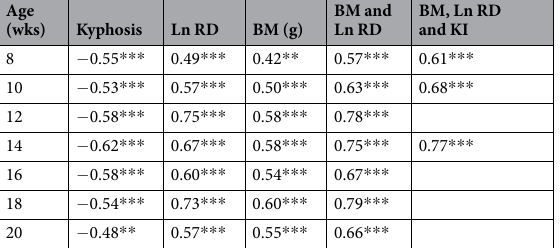
Table 1. Correlates of dko lifespan. Correlations (pearsons r) between lifespan and kyphosis index (KI), the natural logarithm of running distance (Ln RD), body mass (BM), and multiple regression correlation for lifespan using body mass and Ln RD only or all three measures. Only statistically significant ( P < 0.05) correlations are reported. Data are reported for measures taken every two weeks between 8 and 20 weeks of age. ** and *** denote significant correlations at the P < 0.01 and P < 0.001